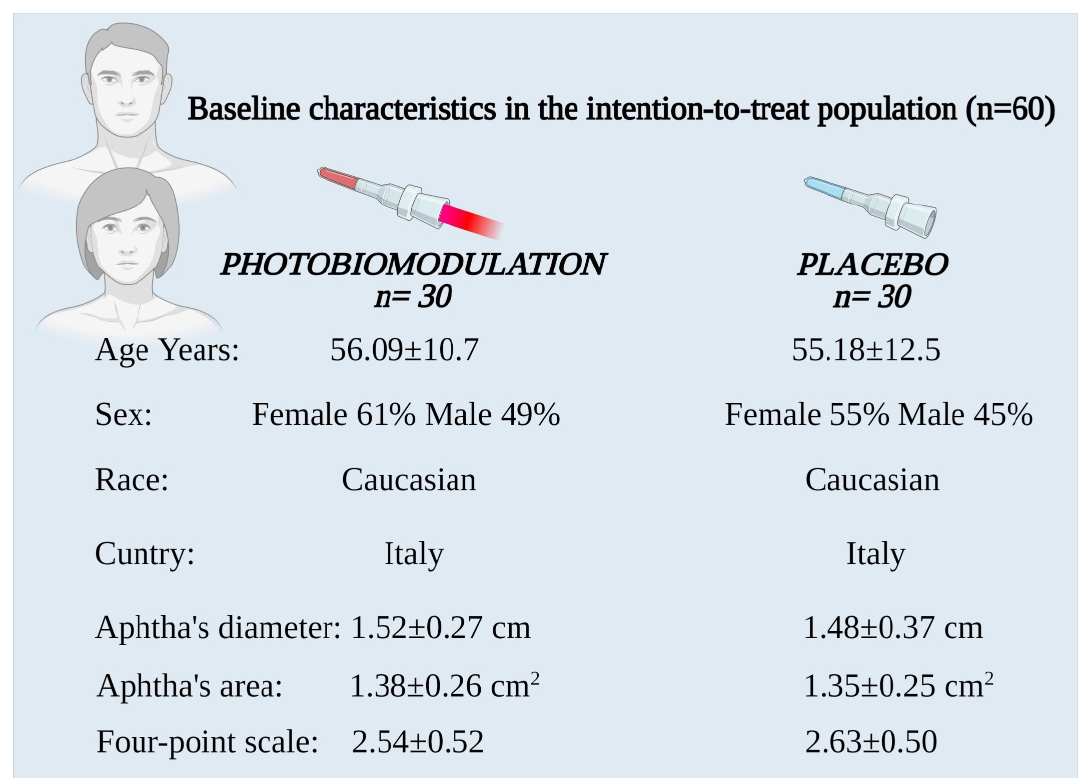
Figure 3. Characteristics of the randomized patients. Image created with BioRender.com. (accessed on 1 April 2021).